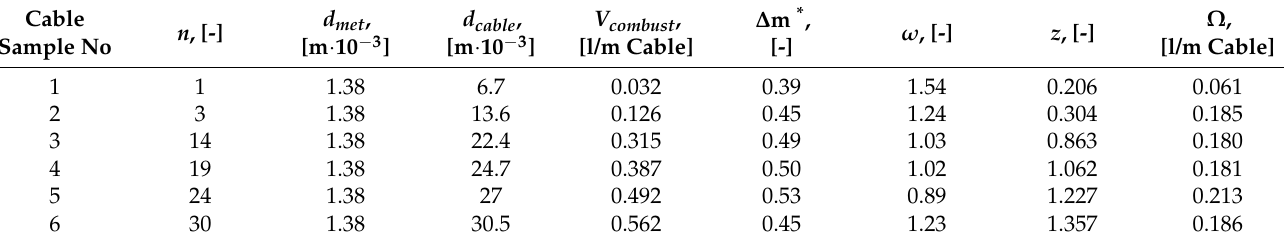
Table 2. Calculation of the Ω cable parameter for tested cable